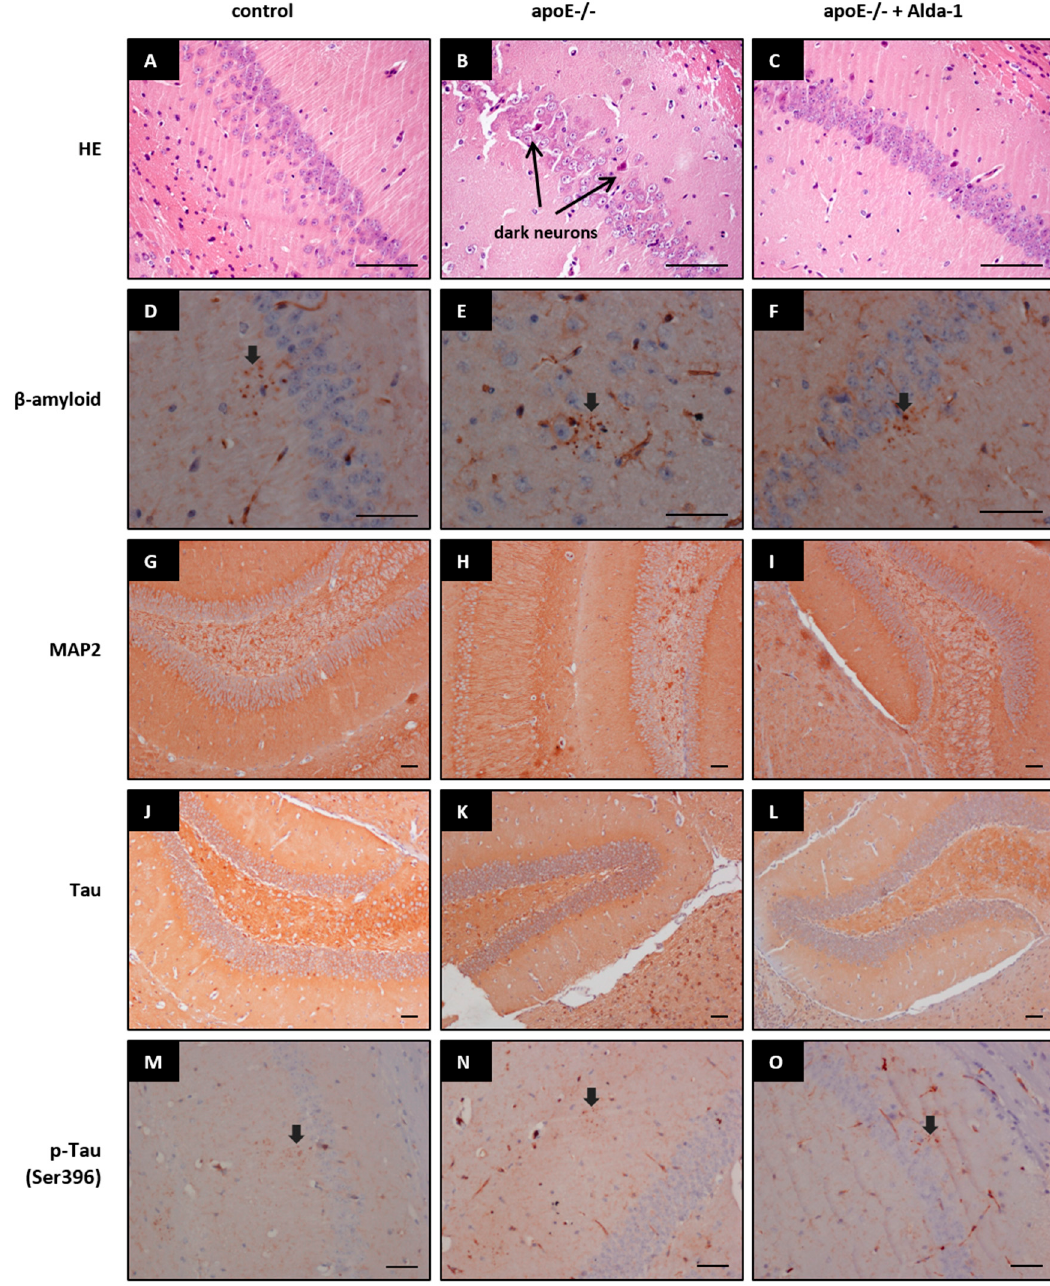
Figure 2. Representative images of hematoxilin and eosin (HE) ( A – C ), β -amyloid ( D – F ), microtubule-associated protein 2 (MAP2) ( G – I ), Tau ( J – L ), and p-Tau (Ser396) ( M – O ) staining in brains of control mice, apoE − / − mice, and Alda-1-treated apoE − / − mice. Arrows indicate dark neurons, positive stainings of β -amyloid and p-Tau (Ser396), respectively. Scale bars = 500 µm.